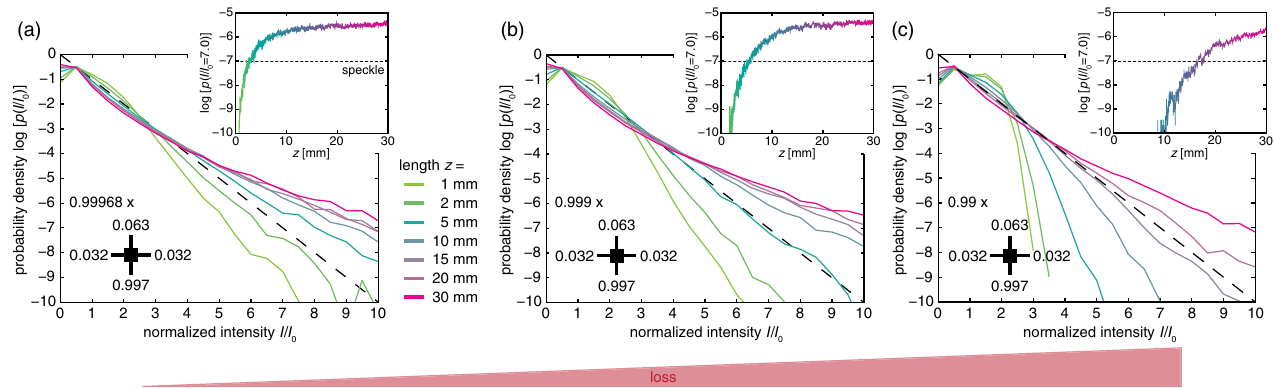
FIG. 15. Numerical results of simulations with an increasing (from left to right) amount of intrinsic losses and otherwise unchanged parameters. Losses enter the simulations in the form of a factor < 1 with which the scattering matrix scattering event. This factor can be interpreted as the square root of the albedo as defined in Sec. IV. Depicted are the cases ffiffiffi p ffiffiffi p 0 . 99968 (a), a ¼ 0 . 999 (b), and a ¼ 0 . 99 (c). As the losses increase, the full extent of enhanced extreme events is delayed to longer propagation lengths, but nevertheless the deviations of the probability density function from a speckle distribution are persistent. This can also be seen in the insets, where we have plotted the dependence of the probability density function at a specific intensity I=I 0 ¼ 7 . 0 on the propagation